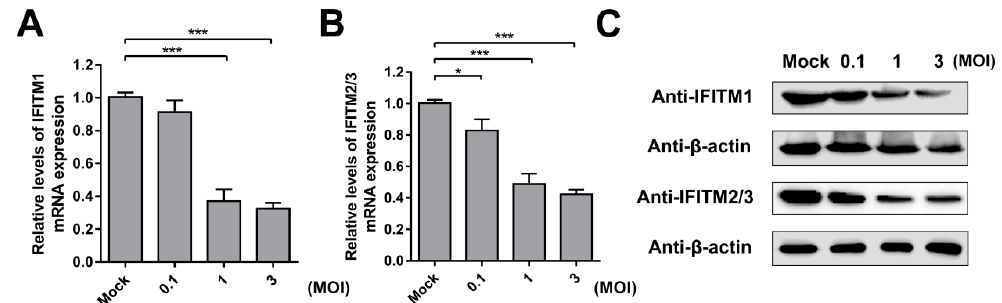
Figure 4. IFITM expression is downregulated by CSFV. RT-qPCR analysis of IFITM1 ( A ) and IFITM2/3 ( B ) mRNA levels (normalized to β -actin expression) in PAMs infected with CSFV at an MOI of 0.1, 1, or 3 for 24 h. Data represent the mean ± SD of three independent experiments and were measured in technical duplicate. Comparisons between groups were performed by Student’s t test. * p <